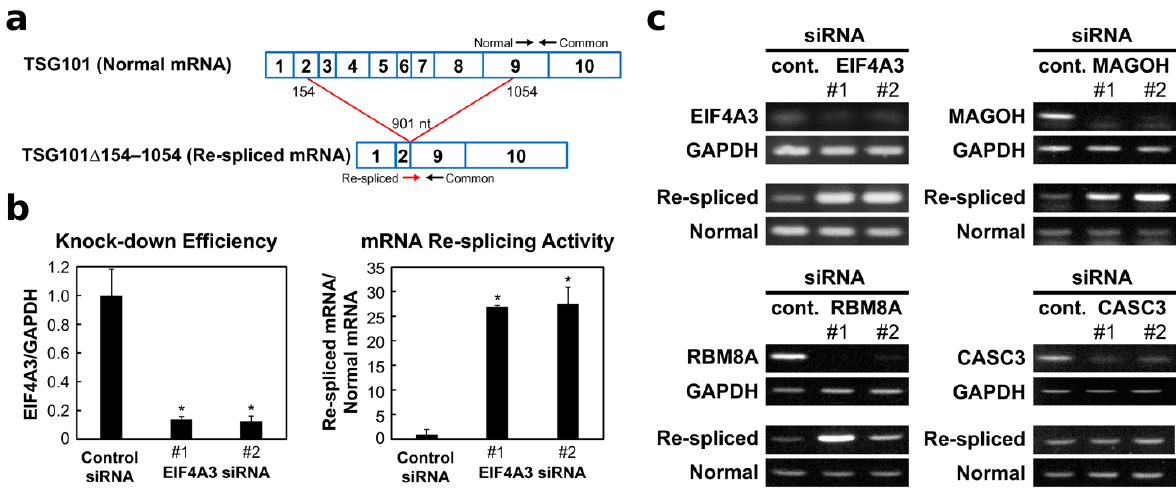
Figure 1. Identification of EJC core factors as repressor candidates of cancer-specific mRNA re-splicing: ( a ) The schematic structure of normally spliced TSG101 mRNA and cancer-specific re-spliced TSG101∆154– 1054 mRNA. The primer sets for the detection are indicated with arrows. ( b ) To measure the generated normal TSG101 and re-spliced TSG101 Δ154 -1054 mRNAs, the extracted total RNAs were analyzed by RT – qPCR using the indicated specific primer sets in ( a ). To knock-down the expression of the endogenous EIF4A3 gene, MCF-7 cells were transfected with EIF4A3 siRNAs together with control siRNA. The cell extracts were then analyzed by RT – qPCR, and the relative amounts of EIF4A3 mRNA were plotted. The histograms represent the means ± standard deviations of three replicates (* p < 0.05). ( c ) To knock-down the expression of endogenous EJC core factor genes, MCF-7 cells were transfected with siRNA targeting EIF4A3, MAGOH, RBM8A, CASC3, or control siRNA (cont.). To observe the knocked-down mRNAs and generated normal TSG101 and re-spliced TSG101 ∆154– 1054 mRNAs, the extracted total RNAs were analyzed by RT – PCR. The depletion of the targeted proteins was verified by immunoblotting (Figure S2).